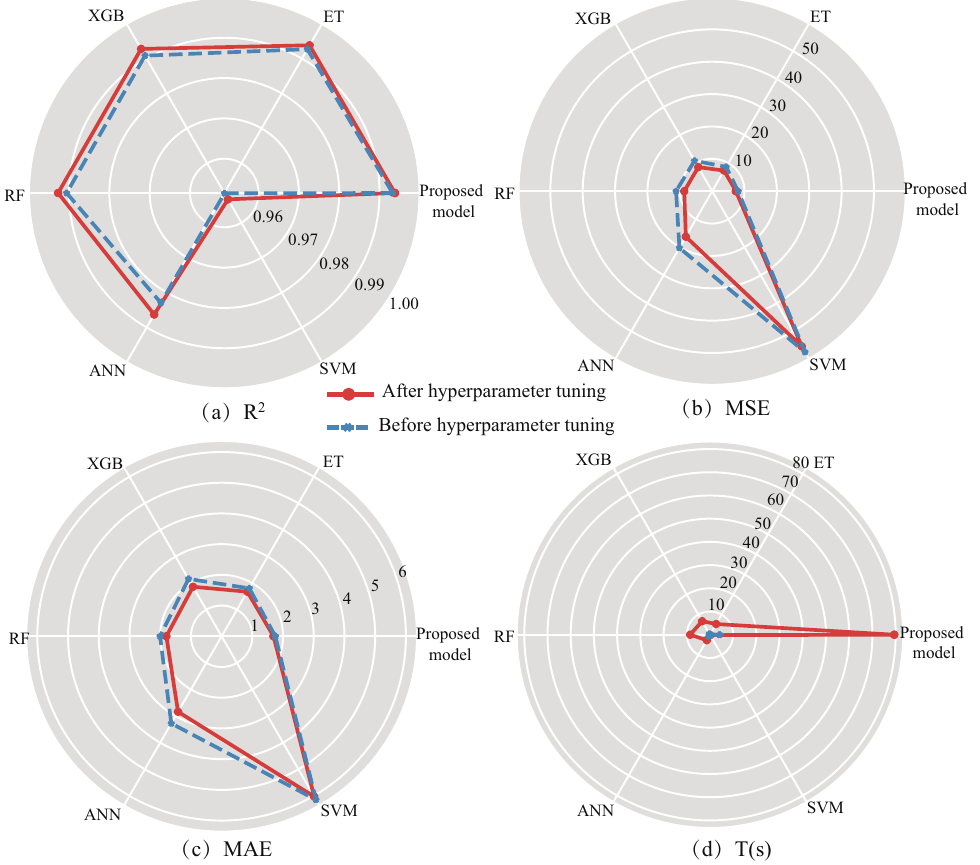
Figure 7. Performance comparison before and after model hyper-parameter optimization: ( a ) R 2 . ( b ) MSE. ( c ) MAE. ( d )